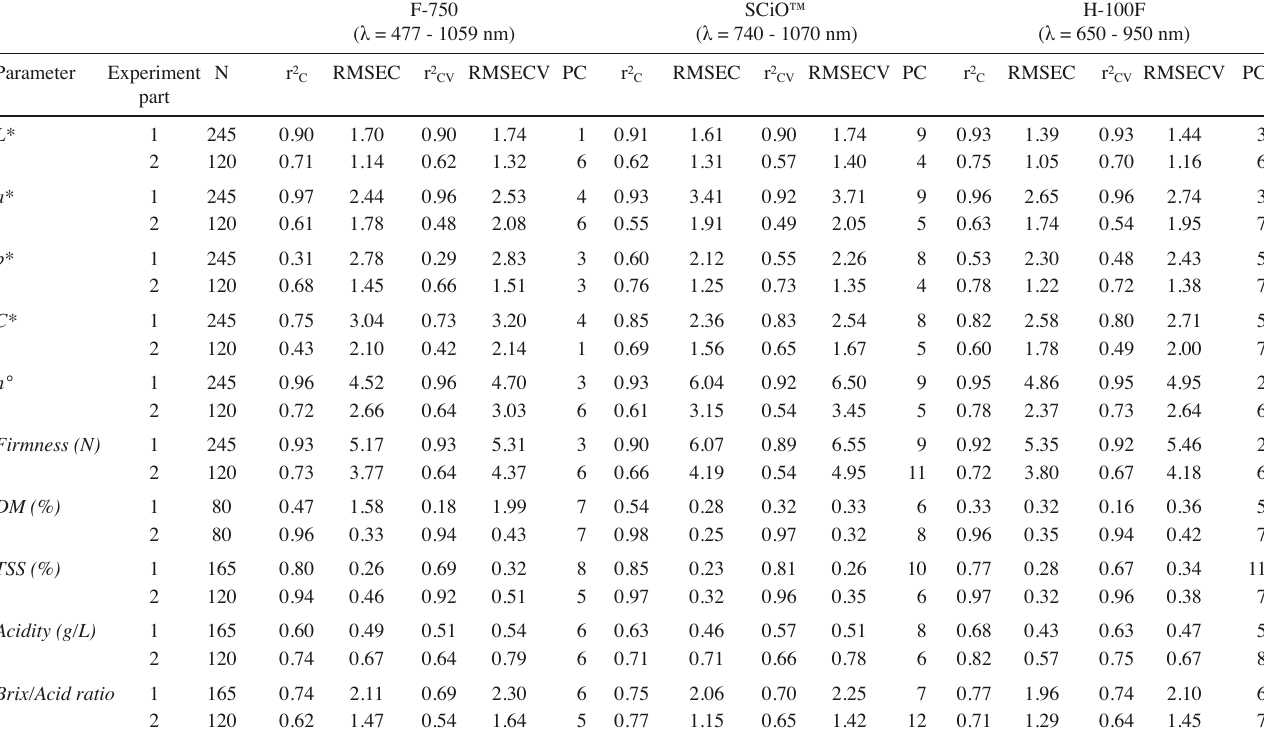
Tab. 4: Prediction of tomato quality parameters of three commercially available NIR devices using The Unscrambler ® software for evaluation. L*, a*, b*, C*, h°: colorimetric values; TSS: total soluble solids; r² C : r² of calibration; RMSE C : root mean square error of calibration; r² CV : r² of cross-validation; RMSE CV : root mean square error of cross validation; PC: principal